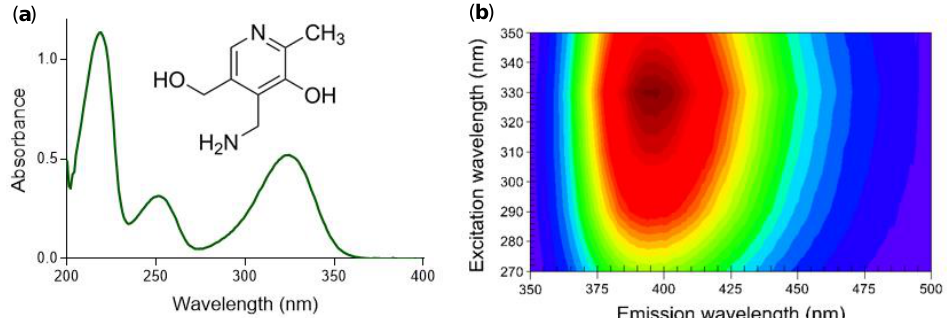
Figure 1. Absorption spectra and structure ( a ) and fluorescence fingerprint (( b ) red, high intensity; blue, low intensity) of pyridoxamine (100 mM, pH 7.0).